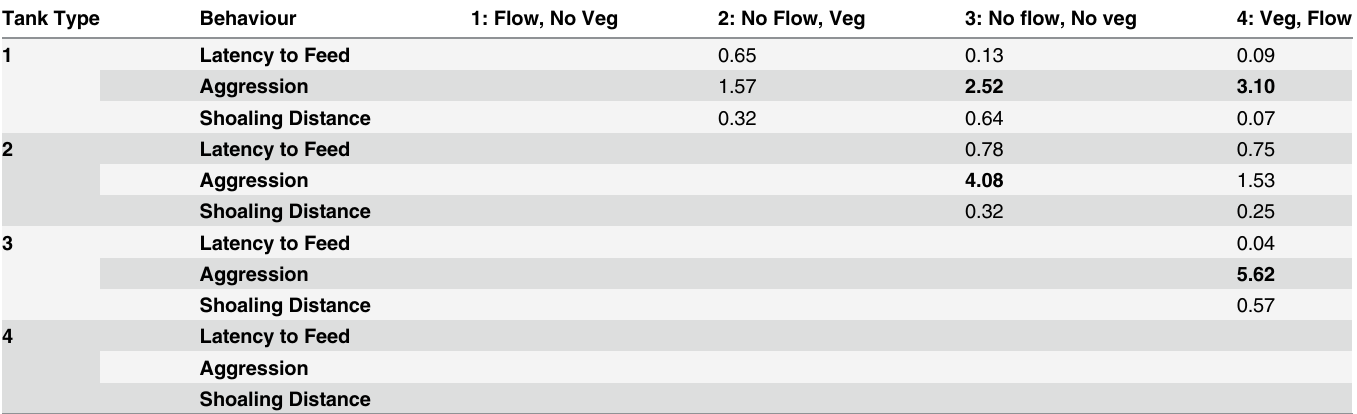
Table 4. Paired comparisons of mean differences across tank treatment types (1, 2, 3 and 4) for (log transformed) Latency to feed, (square-root transformed) Aggression and (log transformed) Shoaling distance measurements. Tank